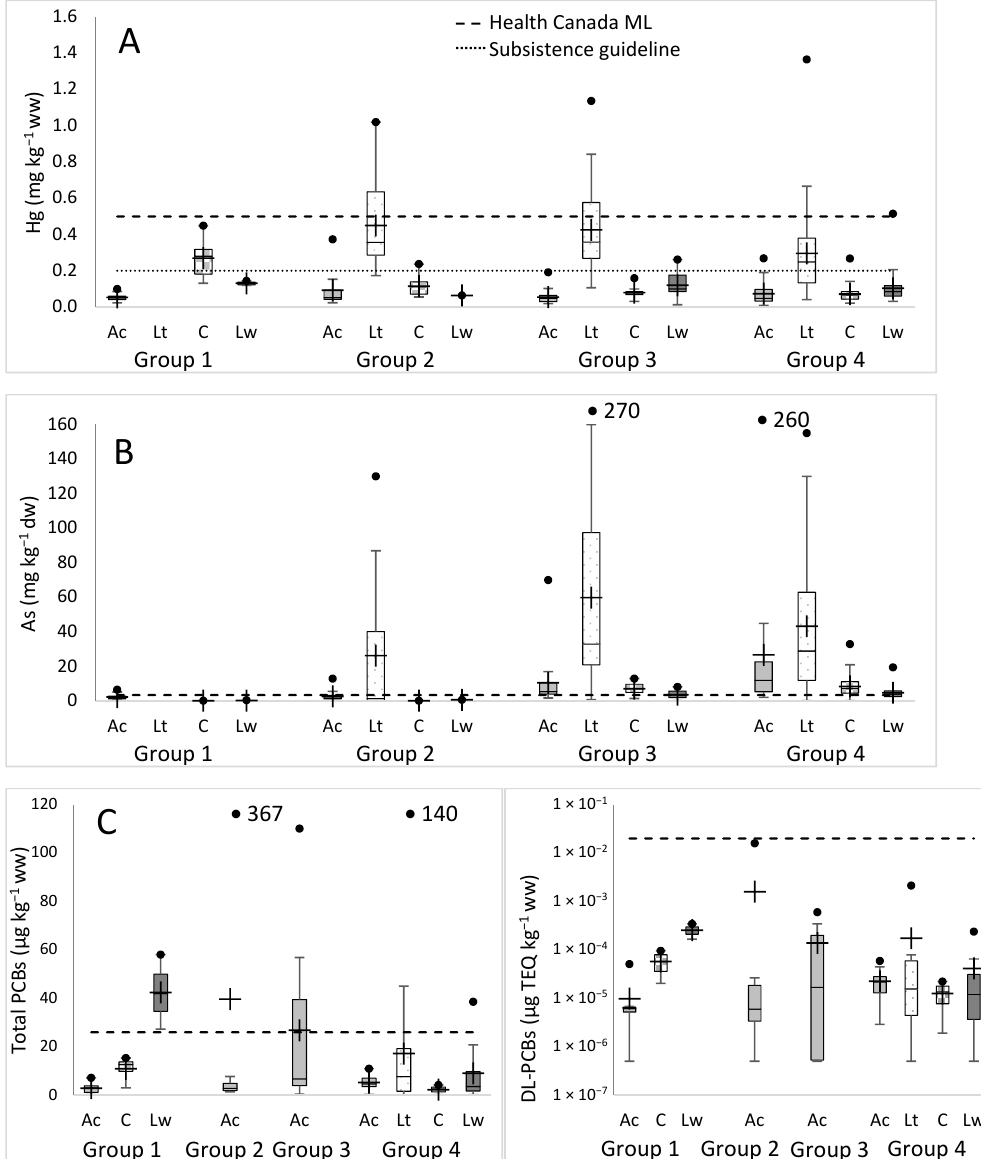
Figure 3: Box plots of A. Hg (µg kg -1 ww), B. As (mg kg -1 dw), and C. total PCB (µg kg -1 ww), left, and Figure 3. Box plots showing contaminants assayed in di ff erent fish and grouped geographically DL-PCB (µg TEQ kg -1 ww), right, concentrations grouped by fish and geographic groups. Ac = Arctic (as shown in Figure 1). ( A ). Hg ( µ g · kg − 1 ww), ( B ). As (mg · kg − 1 dw), and ( C ). PCB total concentrations char, Lt = lake trout, C = cisco, Lw = lake whitefish. Black points are maximum values and crosses are ( µ g · kg − 1 ww) on the left, and DL-PCB ( µ g TEQ kg − 1 ww) on the right. Fish are abbreviated as means. Off-scale maximum values are provided in text boxes. Dotted lines are guidelines. Ac = Arctic char, Lt = lake trout, C = cisco, and Lw = lake whitefish. Black points are maximum values and crosses are means. O ff -scale maximum values are provided in text boxes. Dotted horizontal lines are guidelines or advisories. See the Discussion for Health Canada maximum level (ML) or regulatory limit guidelines and other advisory